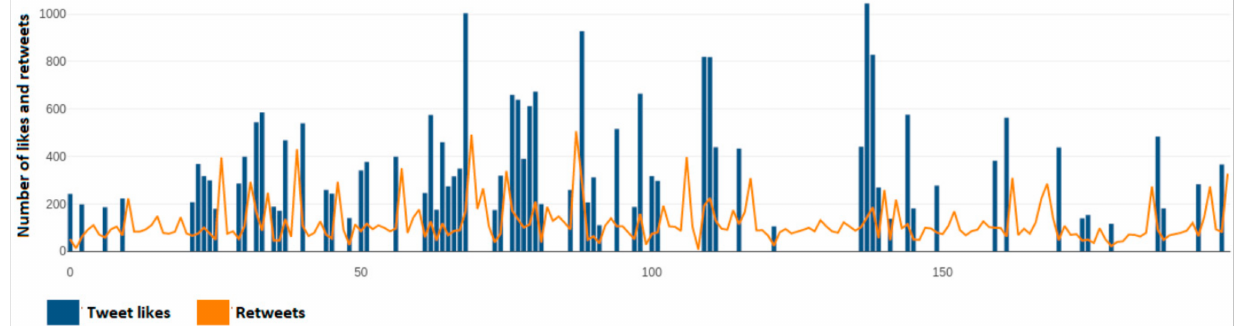
Figure 14. Number of likes and retweets per tweet for @neademokratia (200 tweet sample). Figure 15 depicts the number of user reactions, likes, and retweets of each tweet